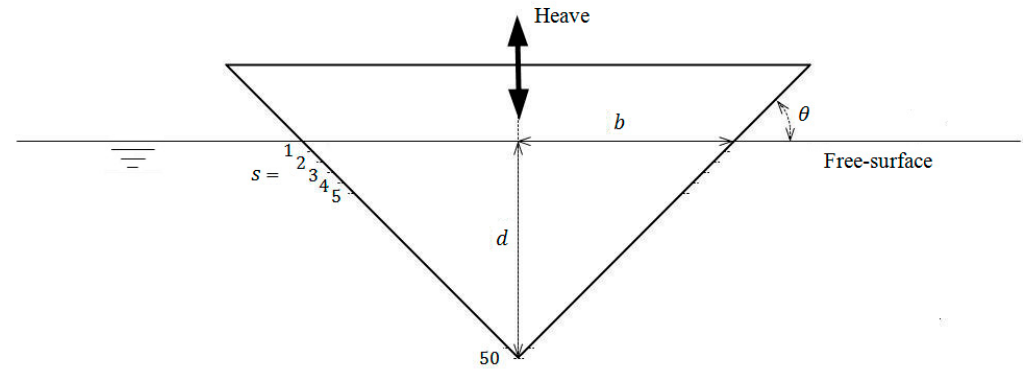
Figure 1. A wedge harmonically heaves on the water surface, with mean draught d = 1 m, half of mean breadth b = 1 m, flare angle θ = 45 ◦ , and heave frequency ω = 0.8 rad/s. Each side of the wetted surface of the wedge are equally divided into 50 segments.